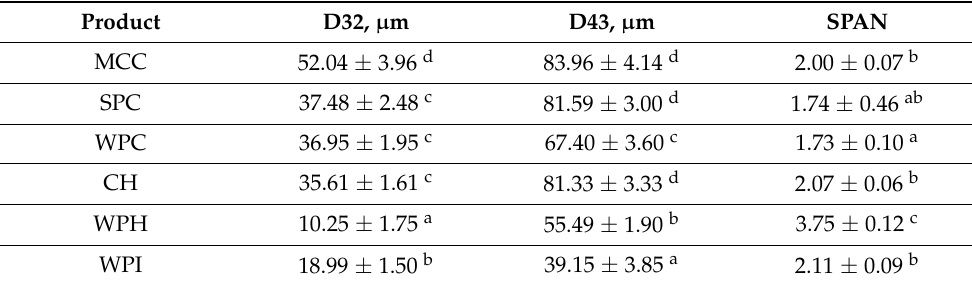
Table 3. Diameter and particle size distribution of high-protein milk